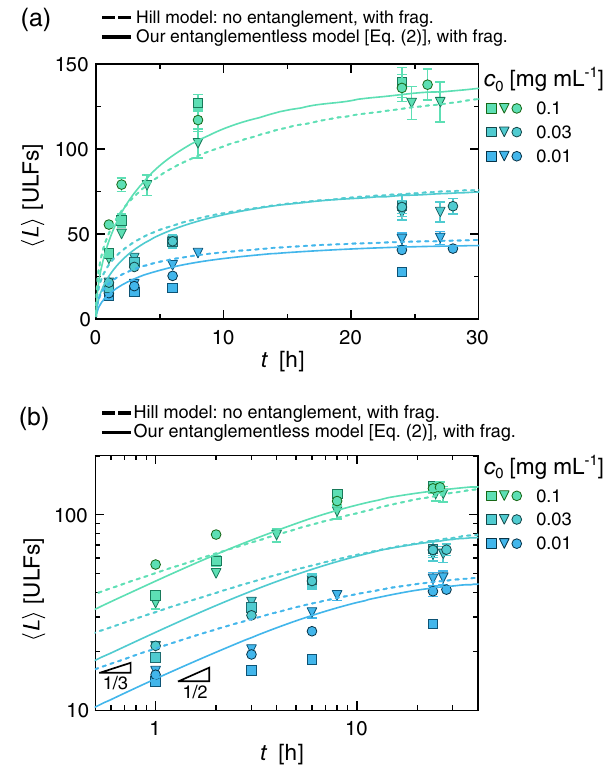
FIG. 9. (a) Fit of the experimental data (symbols) obtained K 1 i − 1 þ j − 1 Þ = 2 using our model for the annealing rate, K i;j ¼ ; 1 ð (solid lines), and the Hill model with fragmentation [Eq. (E2), dashed lines]. (b) Same data as in (a) in double-logarithmic scale. 1 . 00 × 10 − 3 , τ ¼ 13 h. For the Hill model, For our model, K d ¼ 8 . 0 × 10 − 4 , τ ¼ 22 . 0 h. Note that all the data shown in (a) K d ¼ and (b) are for models without entanglement, as the latter are not relevant in this range of